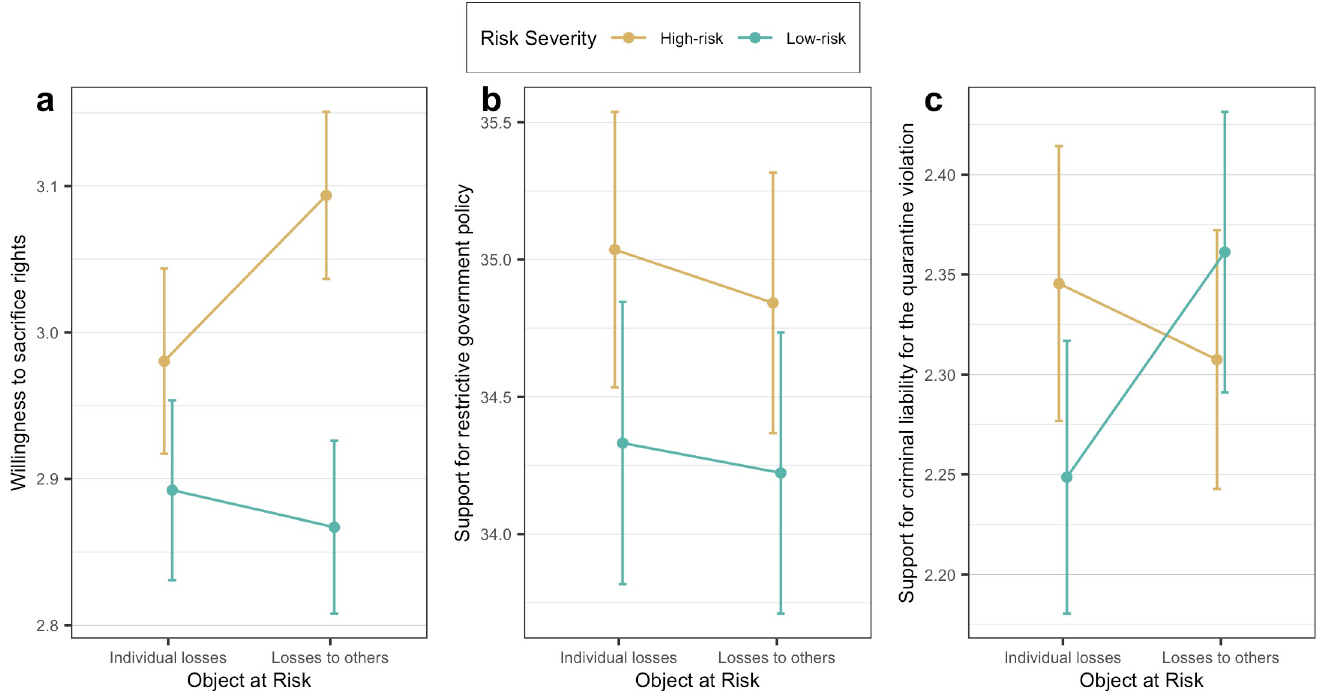
Fig 2. From left to right, the group means with 95% error bars in a) the willingness to sacrifice rights, b) the support for restrictive government policy, and c) the support for criminal liability for quarantine violation.